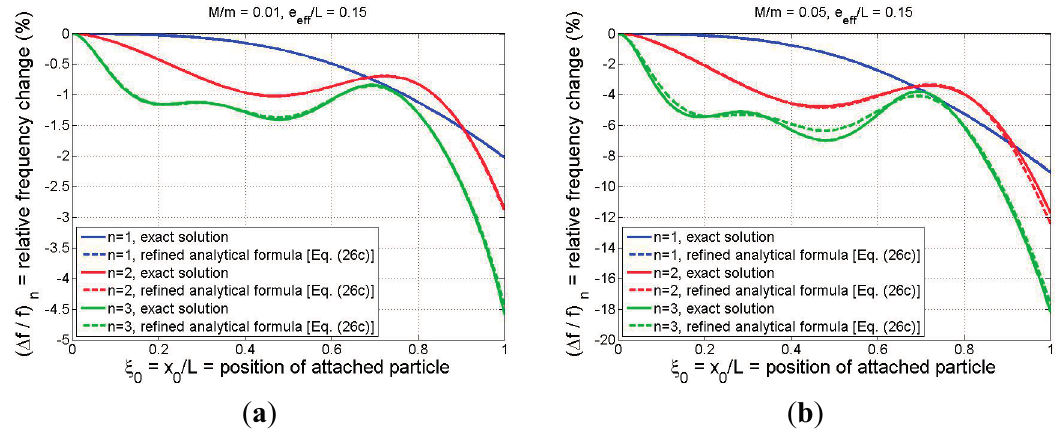
Figure 4. Comparison of relative frequency shift as predicted by the exact model and the refined analytical formula (Equation (26c)): ( a ) M / m = 0.01; ( b ) M / m = 0.05. (For